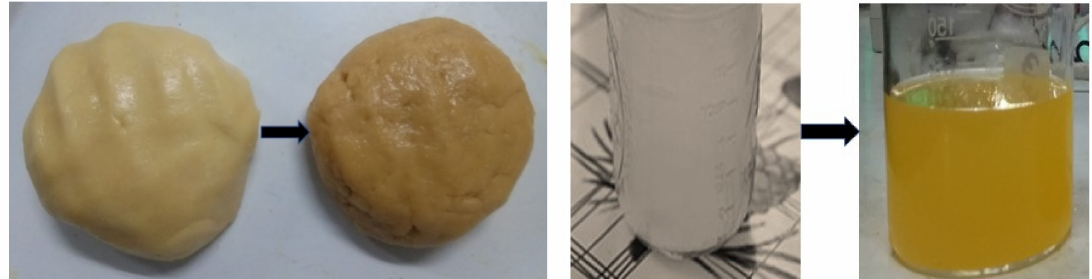
Figure 9. Addition of extracted pigment with cookie dough and lemon juice.